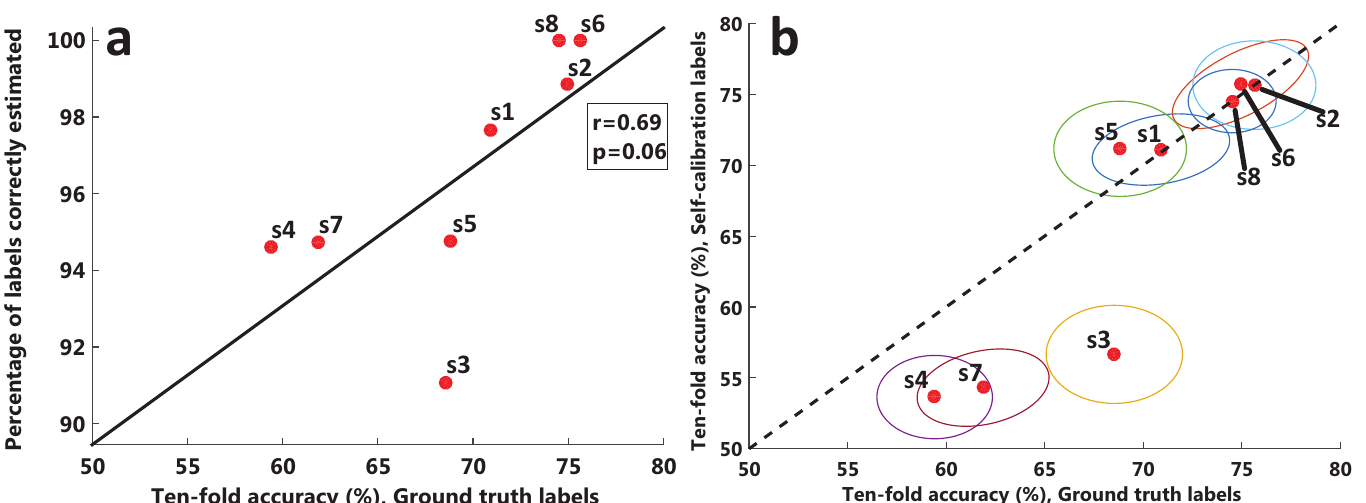
Fig 4. Learned labels quality. (a) Ten-fold accuracy using the ground-truth labels (x-axis) vs percentage of the labels correctly learned by the self- calibration protocol (y-axis), together with the tendency line, where each red dot represents one subject. (b) Ten-fold accuracy using the ground-truth labels (x-axis) compared against the ten-fold accuracy using the labels learned by the self-calibration approach (y-axis). Each dot represents one subject, whereas the ellipsoid represents the uncertainty computed from the ten-fold accuracies. Every dot below (above) the dashed line implies that the self-calibration approach had worse (better) accuracies than the ground-truth